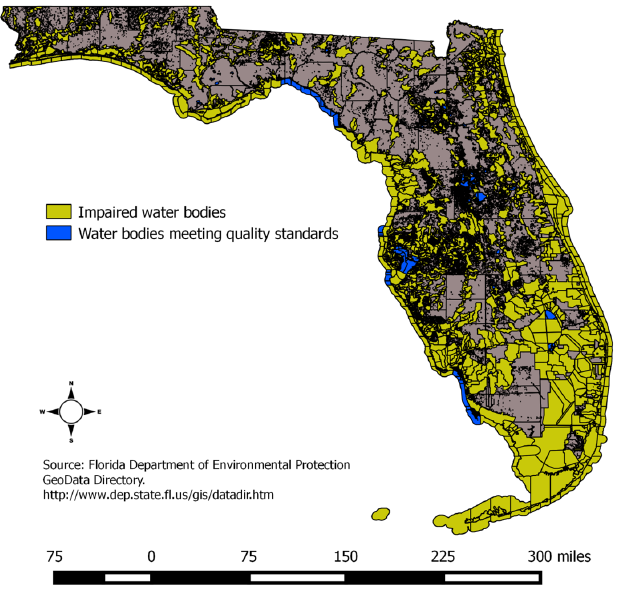
Figure 1. Impaired surface water bodies of Florida.